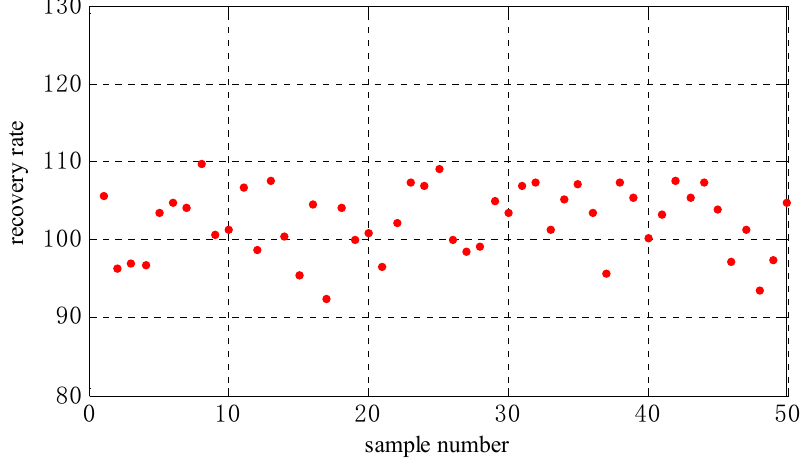
Figure 11. The recovery rate of ICSO-SVM.